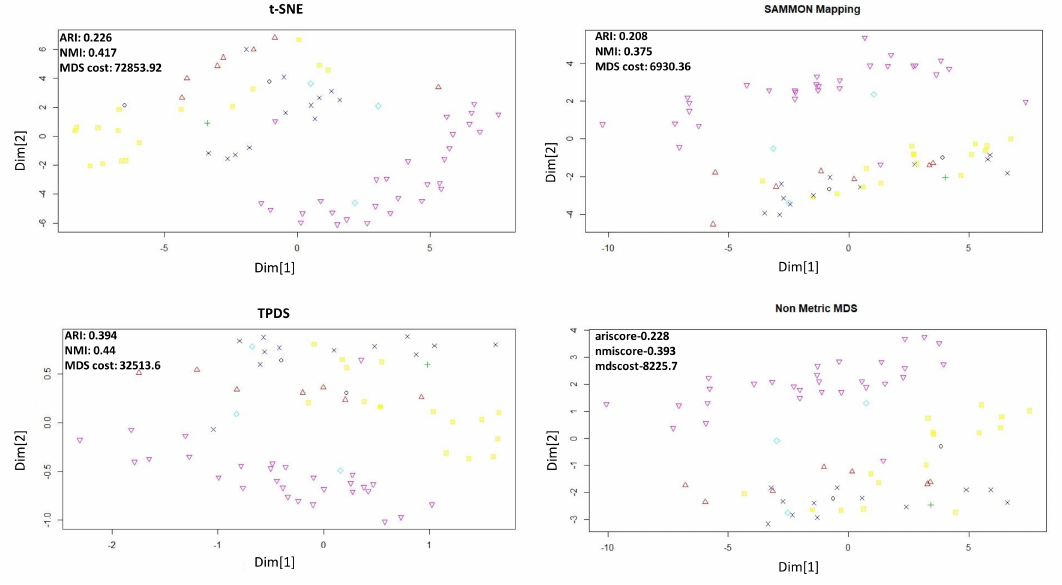
Figure 4. Dimension reduction of SCADI data set.The adjusted Rand Index and Normalized mutual information (NMI) were calculated after performing k-mean clustering using k =